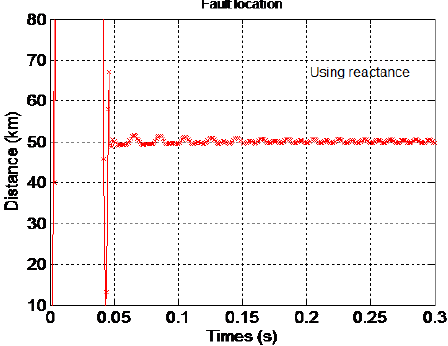
Fig. 6: Fault location as function of time using the re-